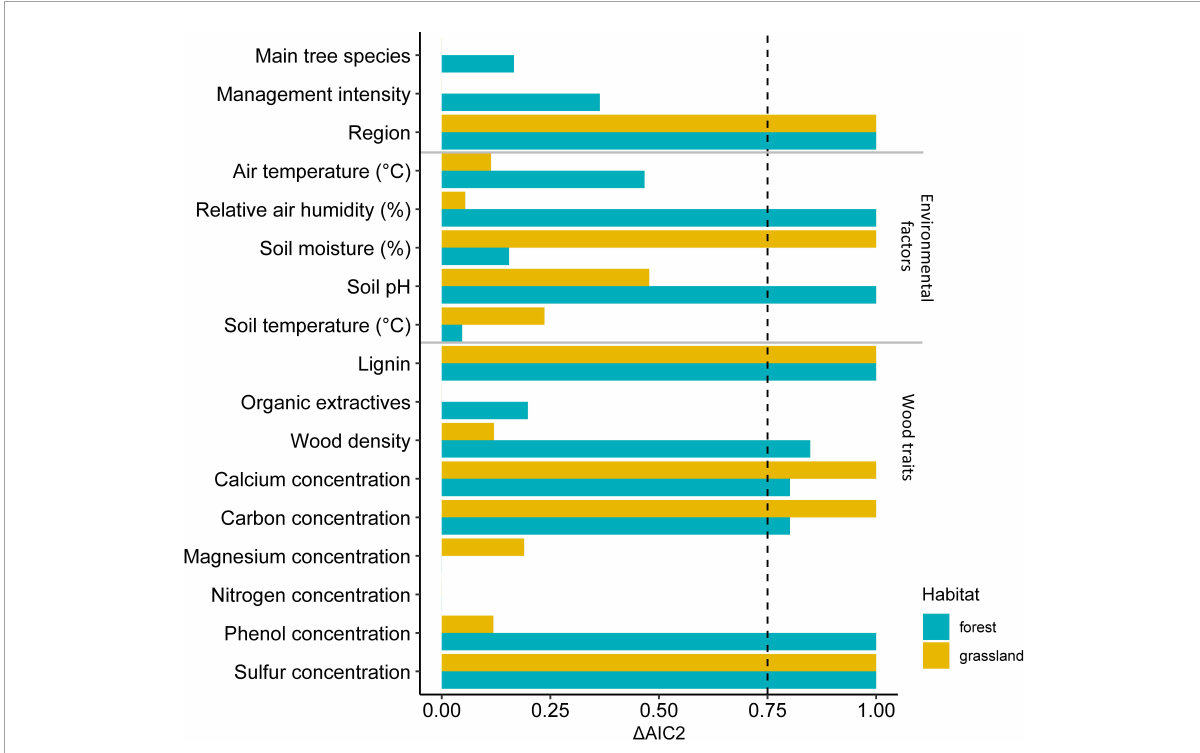
FIGURE3 Importance factors (assessed by the cumulative Akaike information criterion (AIC) weights of models containing a particular predictor) of fixed variables in explaining decay rates of the 13 different tree species based on model averaging with (cid:49) AIC < 2. Values are shown separately for grassland and forest habitat and used with an importance value > 0.75 in a final model ( Figure 4 ). For details see Supplementary Figures 2–5 in the Supplementary material .